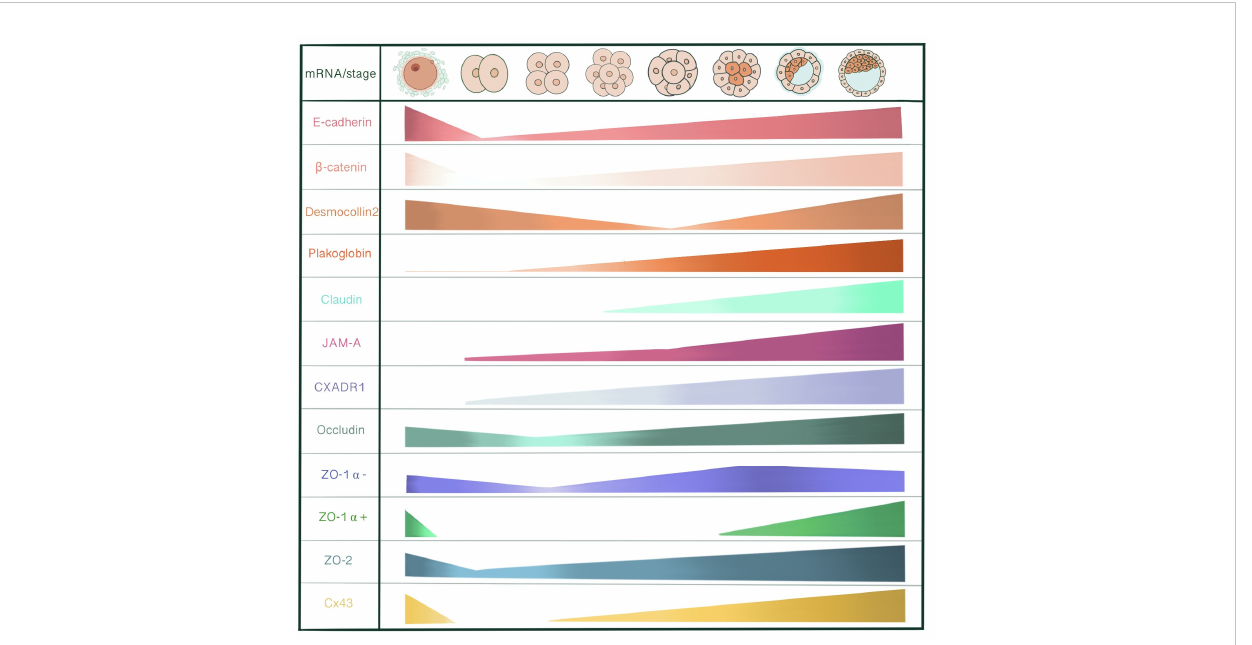
FIGURE 6 Schematic presentation of different junctional mRNA expression levels, adapted from the northern blot and RT-PCR results from mice, shown in order as cumulus-oocyte-complex, 2-cell, 4-cell, uncompacted 8-cell, compacted 8-cell, 16-cell, early blastocyst and late blastocyst stages. Junctional protein mRNA expression is temporally regulated, with distinct changes parallel to zygotic genome activation. Initially, early embryo development is directed by maternal mRNAs and proteins. Reprogramming of gene expression through the elimination of maternally deposited gene products and global activation of the zygotic genome allows maternal genome control to pass over to the zygotic genome, which predominantly occurs at the 2-cell stage in mice. Plakoglobin is very faintly detected at unfertilized eggs and the 2-cell stage, indicating a basal expression level and increases in the following developmental stages. Claudin 4, 6, 7, and 12 are detected at precompact 8-cell stage embryos. However, data is not present for mouse oocytes, zygotes and early cleavage-stage embryos. In porcine embryos, claudin 7 is present in MII oocytes as well as all developmental stages, with a signi fi cant increase at the 8-cell stage. JAM-A is not present within unfertilized eggs and starts to be detected at 2-cell stage blastomeres. However, there is no data regarding cumulus cells. CXADR1 is present in MII oocytes and increases thereafter, but there is no data regarding cumulus cells. CXADR 2 and 3 start to be detected at the morula and blastocyst stages, respectively, which is not shown in this fi gure. While ZO-1 a - is present in both cumulus cells and unfertilized eggs, ZO-1 a + is only present in cumulus cells. Cx43 is present within cumulus cells, oocytes and zygotes, whereas it is absent at the 2-cell stage. It increases continuously starting from the 4-cell stage